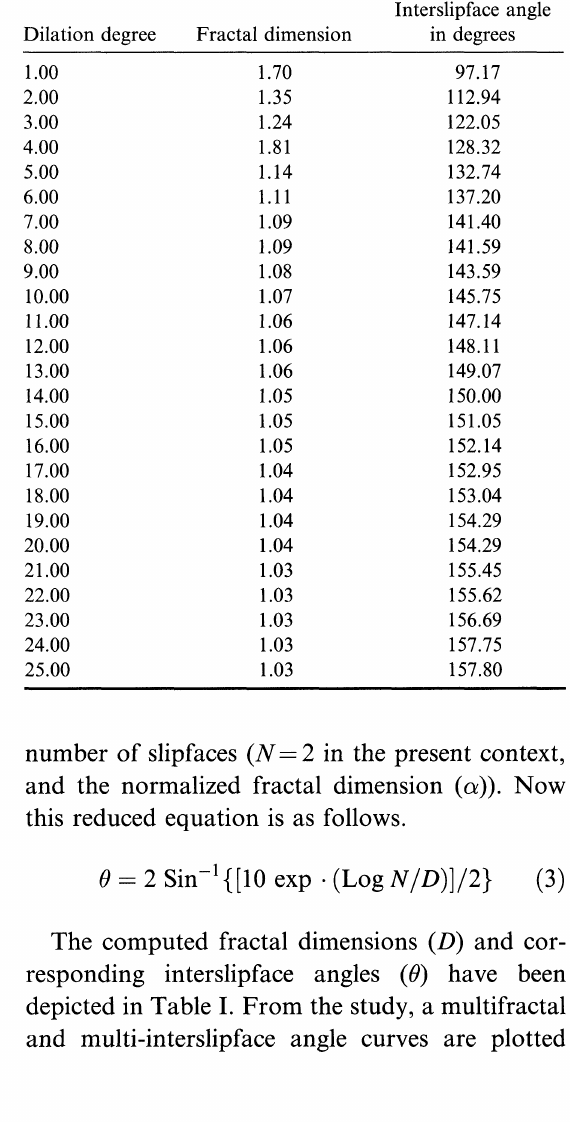
Interslipface angle